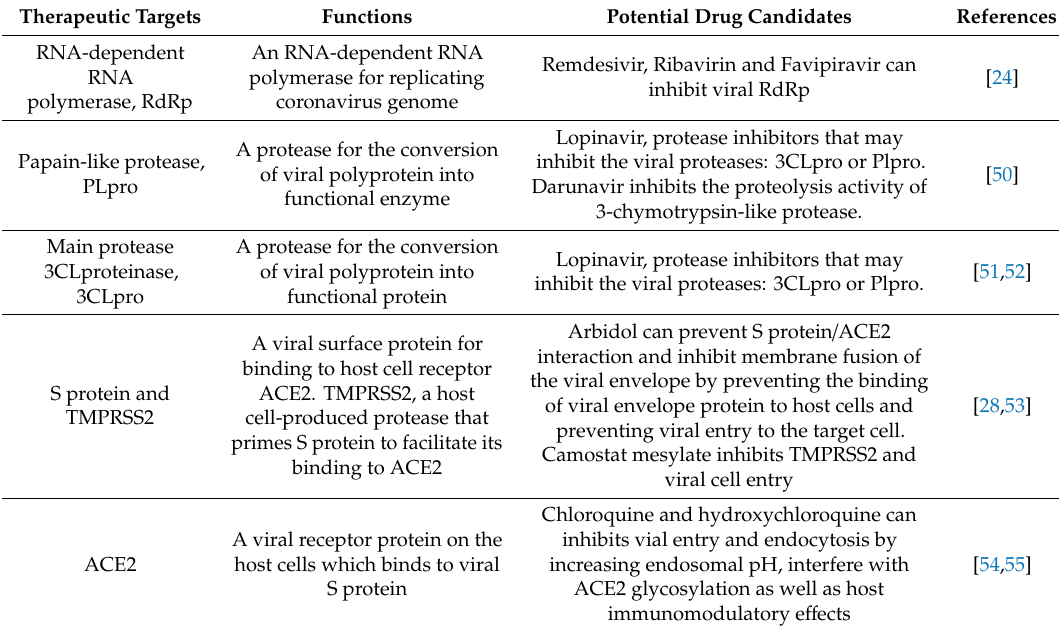
Figure 4. Structure of SARS-CoV-2 RNA polymerase NSP12 complex with NSP7 and NSP8 co-factors (PDB: 6M71). Chain A is highlighted in light sea green, chain B is shown as blue, chain C is highlighted in cyan, chain D is highlighted in purple. Table 1. Potential pharmacological therapeutics for